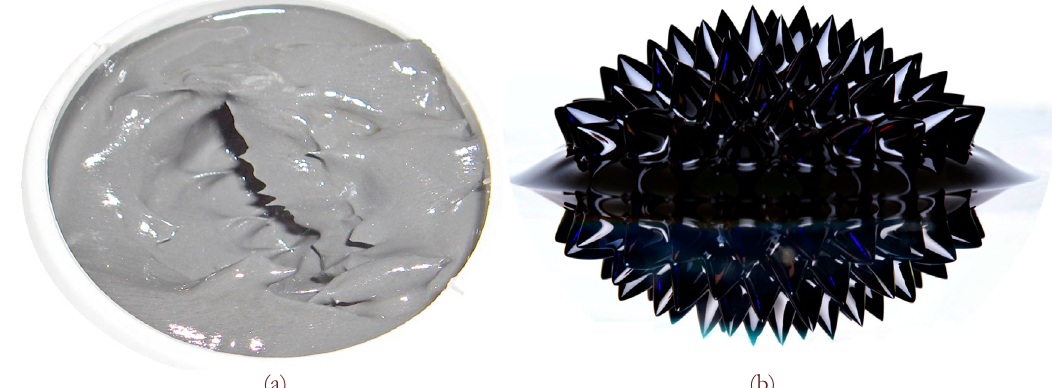
Figure 2: Magneto rheological fluid (a) from Lord [1] and ferrofluid (b), produced by [2].